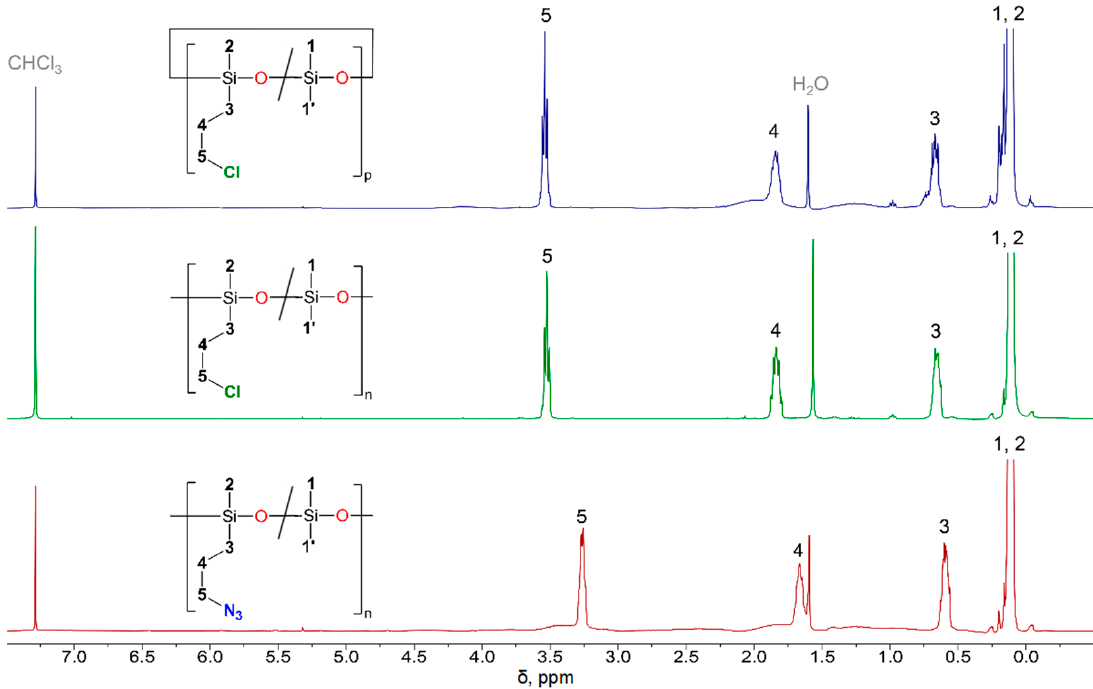
Figure 1. 1 H NMR spectra of Cl-CMSs (blue), Cl-PDMS (green), and N 3 -PDMS (red) with CDCl 3 as a solvent.